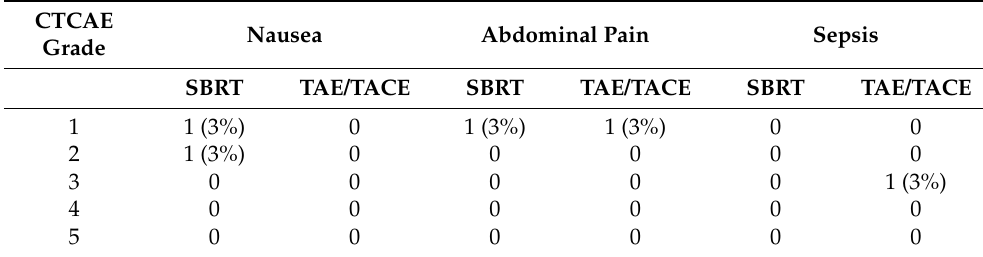
Table 3. Summary of treatment-related adverse toxicity events. CTCAE: Common Terminology Criteria For Adverse Events. SBRT: Stereotactic Body Radiotherapy. TAE/TACE: Transarterial Embolization/Transarterial